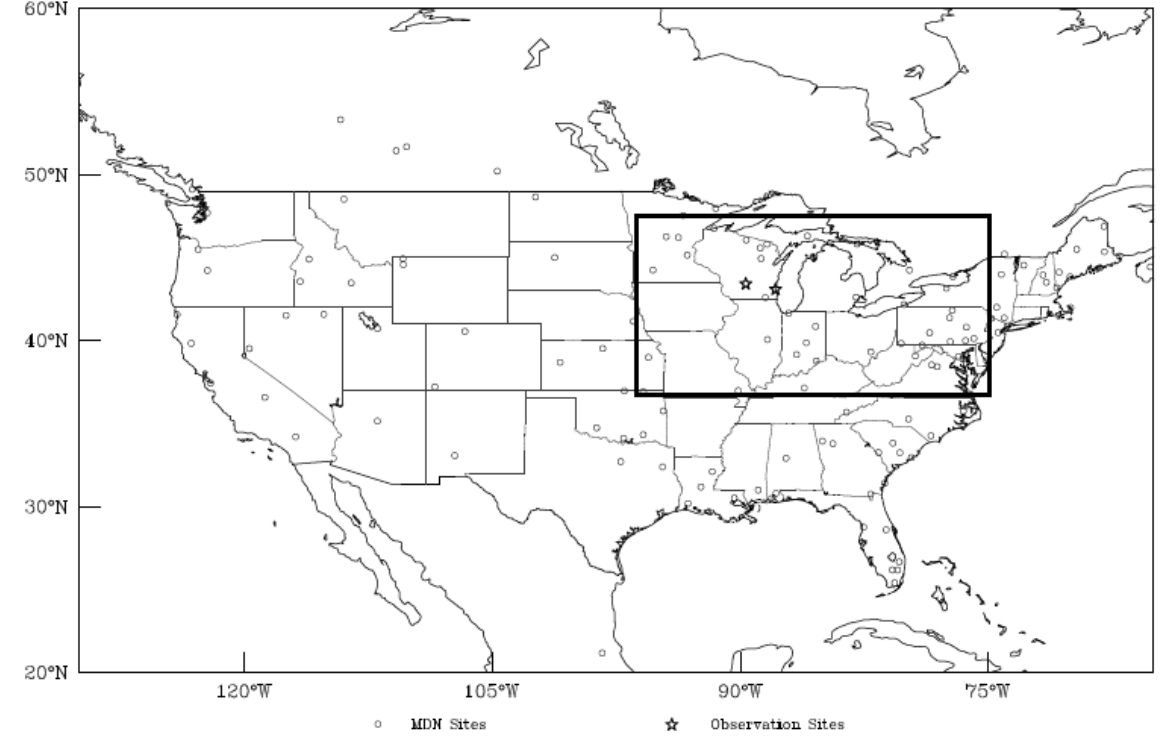
Fig. 1. Domains used for CMAQ-Hg simulations: large box shows the CONUS domain, small box shows the GLR domain. Open circles show locations of MDN monitoring sites; those within the smaller box were analyzed in Table 1. Stars show locations of DL and MKE monitoring